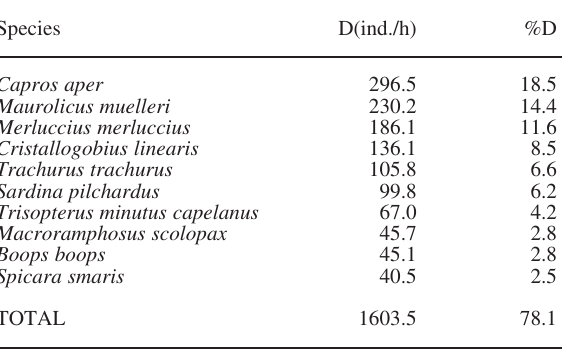
T ABLE 5. – Main fish species caught from shelf depths ordered by decreasing order of abundance (ind/h) during the MEDITS–99 survey. %D: percentage of